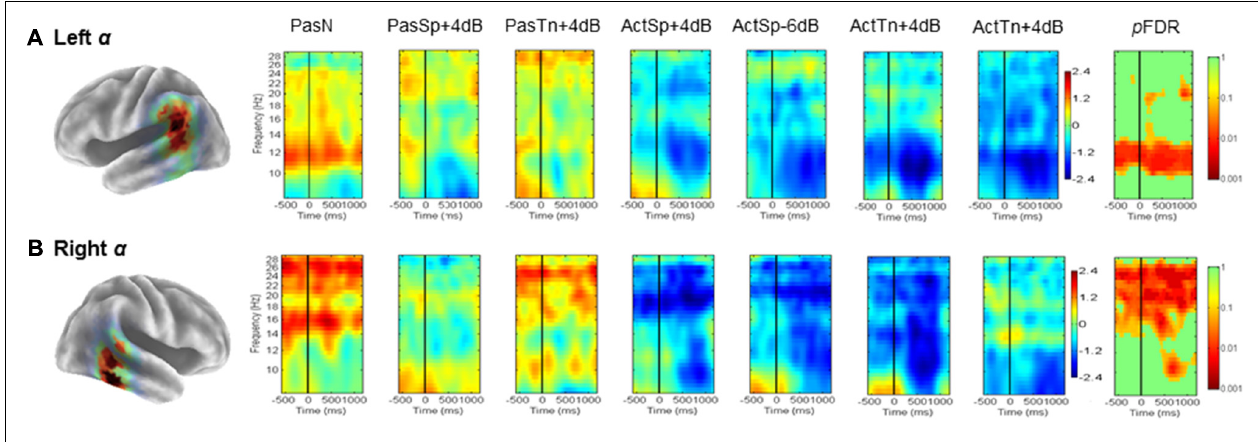
FIGURE 3 | Mean left and right hemisphere α time–frequency ERSPs (event-related spectral perturbations). ERSPs in root-mean-square decibel units as a function of condition (1 × 7) in the left (A) and right hemispheres (B) . FDR corrected p -values indicating significant effects in the beta